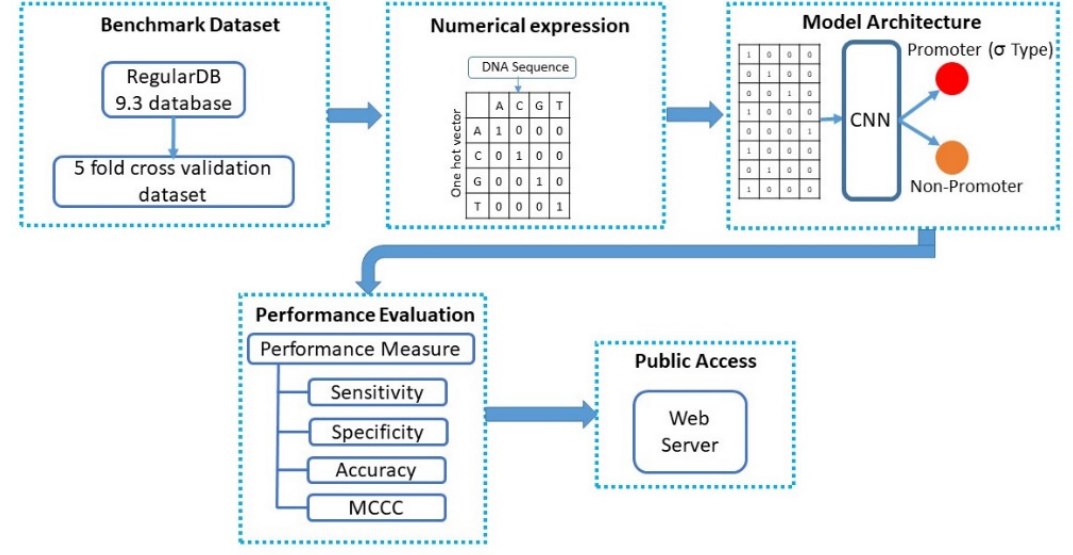
Figure 1. Model overview of pcPromoter-convolutional neural network (CNN).